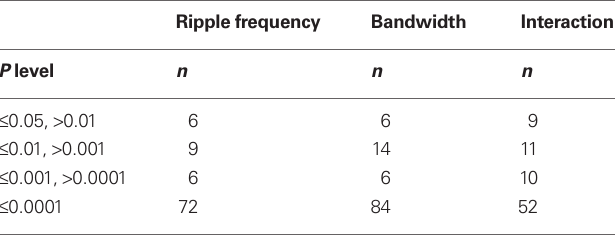
Table 1 | P levels for the ANOVA tests ( F ratios) for effects of ripple frequency, bandwidth, and the interaction between these factors.